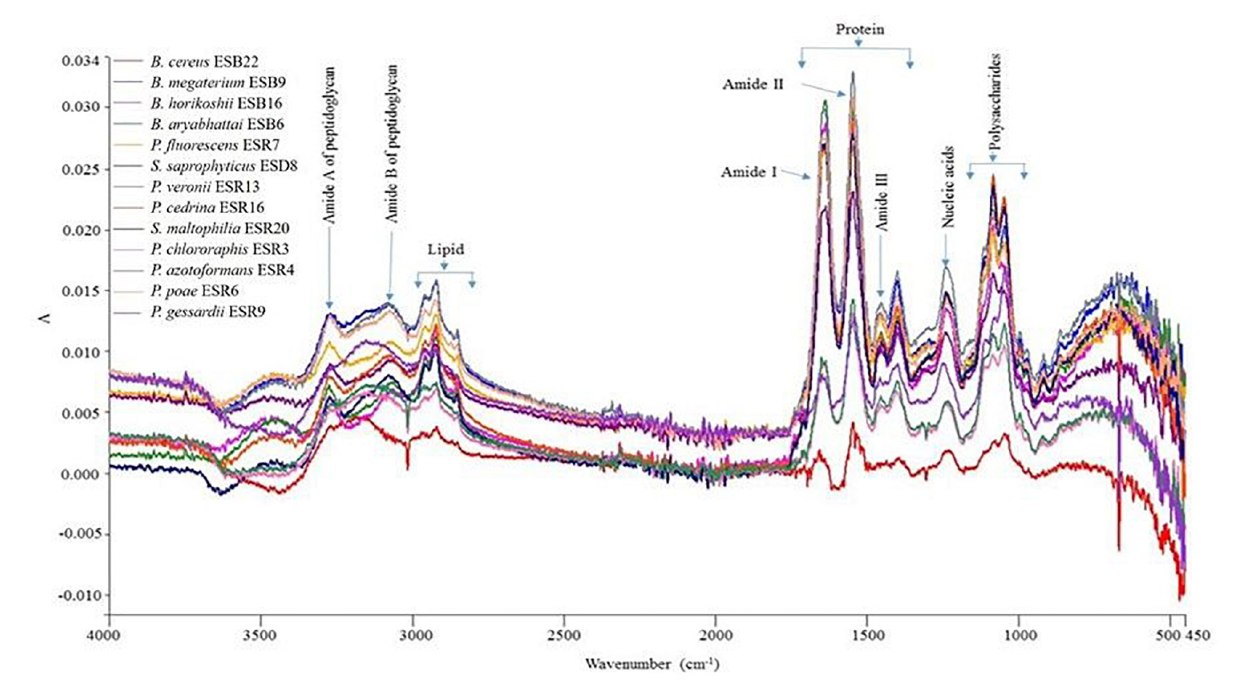
FIGURE 3 | Detection of organic macromolecules constructed by different biofilm-producing PGPR by FTIR.